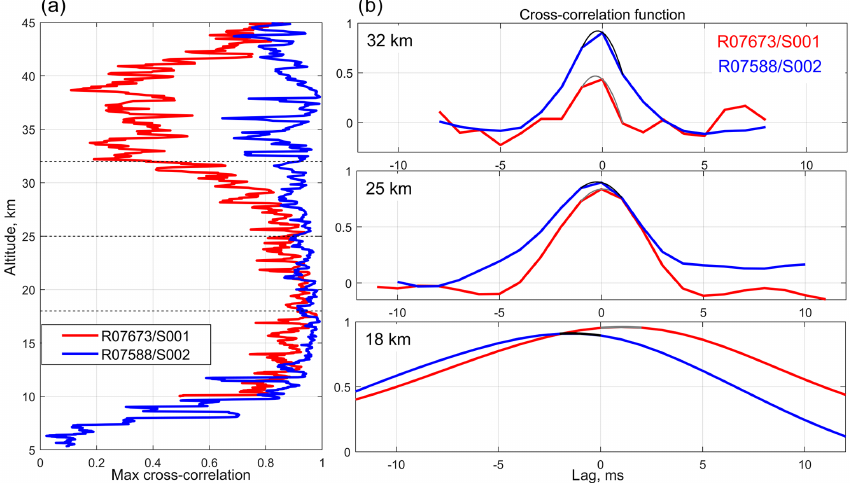
Figure 4. (a) Maximum of cross-correlation function for two GOMOS occultations: R07673/S001 (64 ◦ S 68 ◦ W, β = 23 ◦ , 19 August 2003 04:09:23UTC), red line, and R07588/S002 (35 ◦ S 135 ◦ W β = − 2 . 6 ◦ 13 August 2003 07:28:35UTC), blue line. (b) Examples of cross- correlation functions at selected altitudes and their fit with the parabola (black and grey